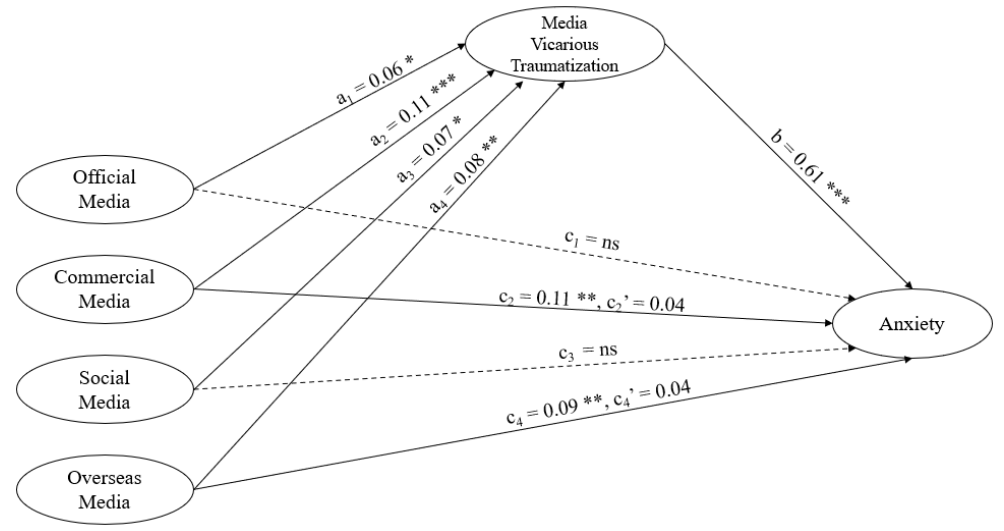
Figure 4. Media exposure and anxiety mediated by media vicarious traumatization. * p < 0.05; ** p < 0.01; *** p < 0.001.